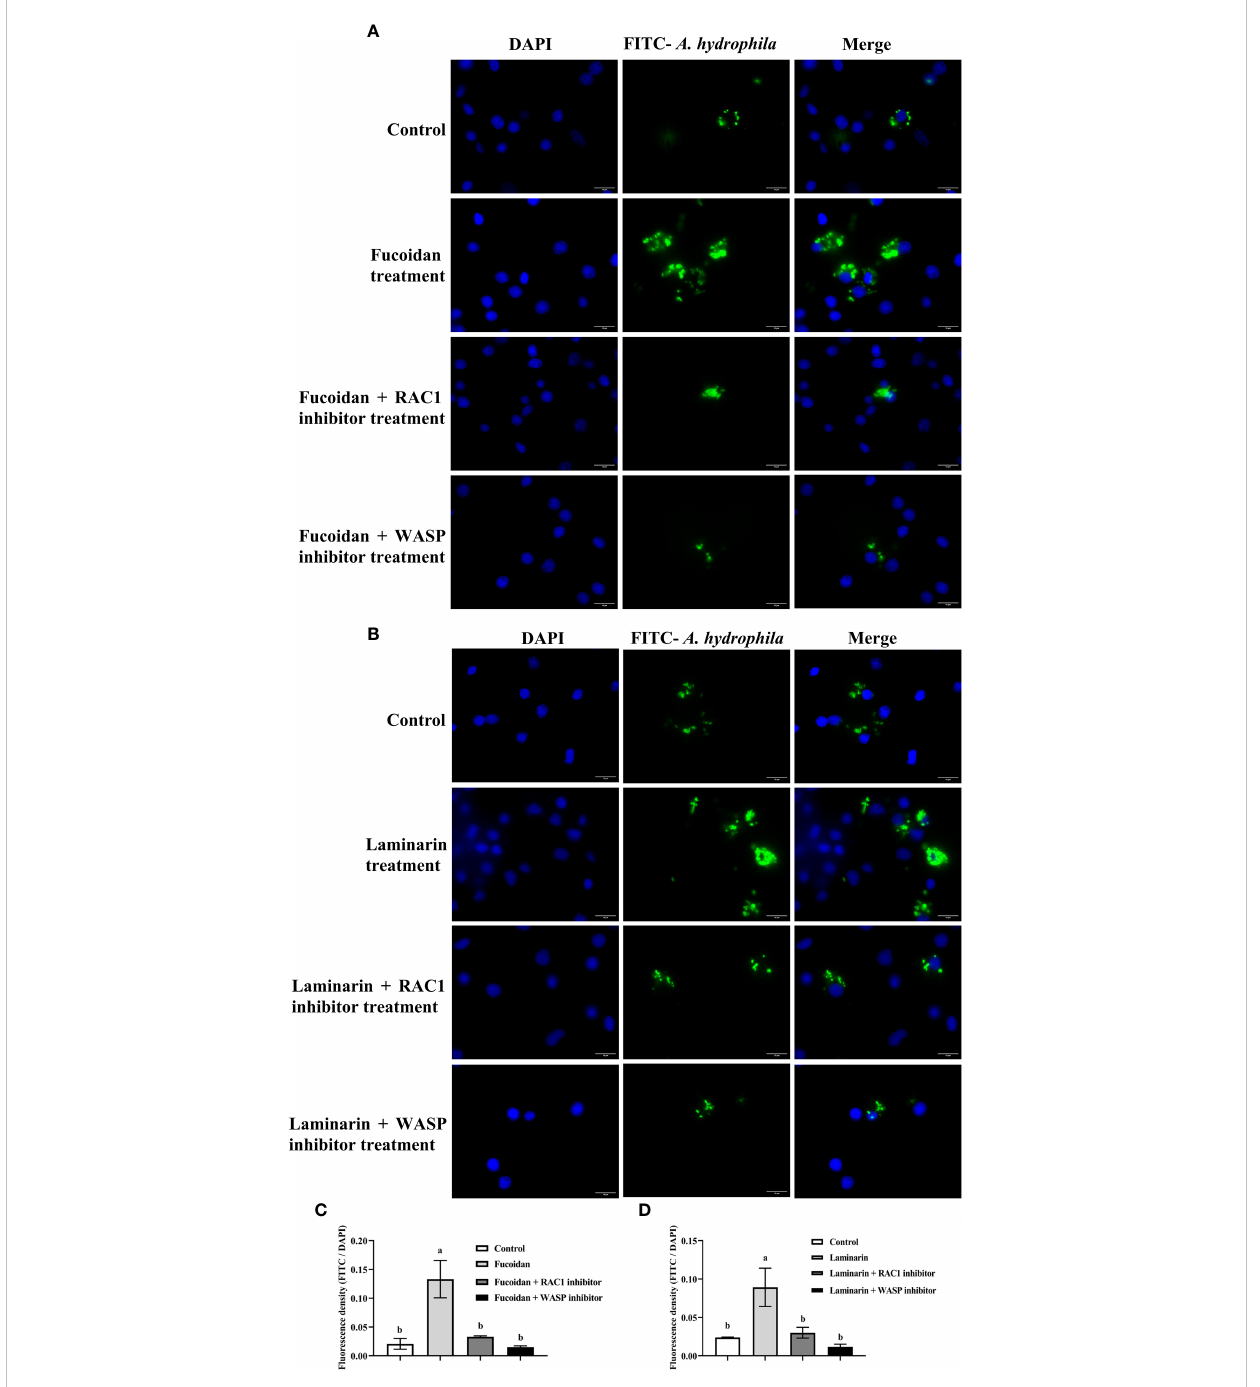
FIGURE 5 Effects of RAC-1/WASP on the phagocytosis of macrophages that induced by seaweed polysaccharides. (A) Blocking effects of RAC-1/WASP inhibitors on fucoidan-induced phagocytosis; (B) Blocking effects of RAC-1/WASP inhibitors on laminarin-induced phagocytosis; (C, D) Quanti fi cation of the blocking effects RAC-1/WASP inhibitors on seaweed polysaccharides-induced phagocytosis, different alphabets indicate signi fi cant differences (P < 0.05). Scale bars = 10 m